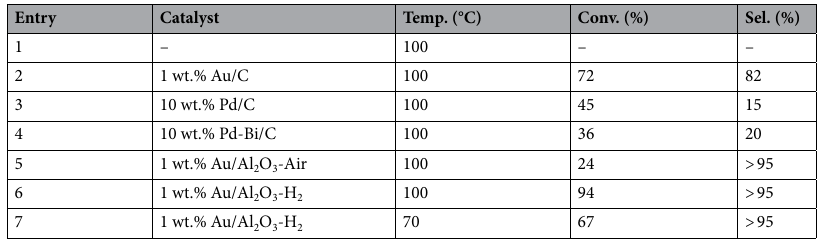
Table 2. d-Ribose oxidation under different conditions. Reaction conditions: 0.15 g of d-ribose in 10 mL of H 2 O, 36 mg of catalyst, 2 h, 1 MPa O 2 . The Au loading of the prepared catalysts is 1 wt.%, and ribose/Au (molar ratio) = 550/1. The conversions (conv.) of ribose and selectivity (Sel.) for ribonolactone were determined by the HPLC